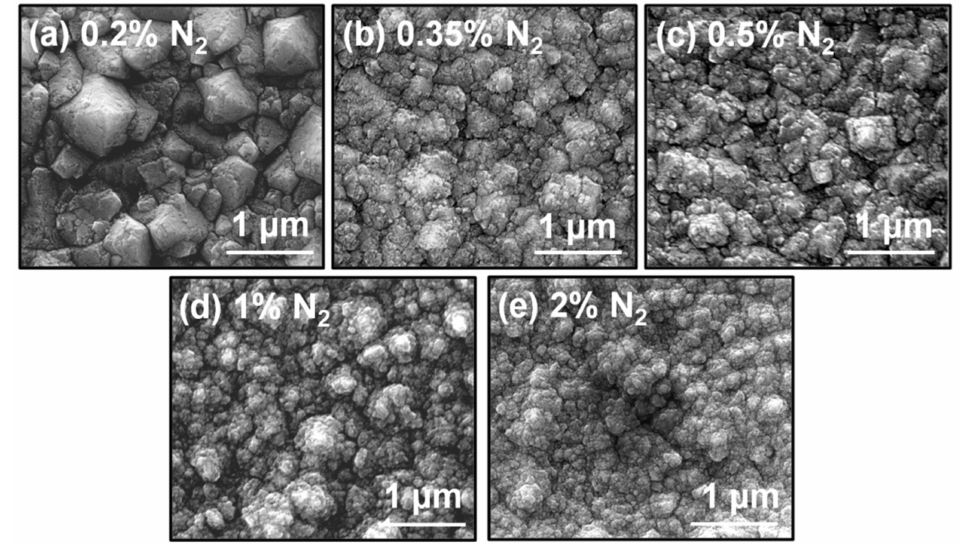
Figure 1. SEM micrographs of the samples grown with ( a ) 0.2% N 2 , ( b ) 0.35% N 2 , ( c ) 0.5% N 2 , ( d ) 1% N 2 and ( e ) 2% N 2 .